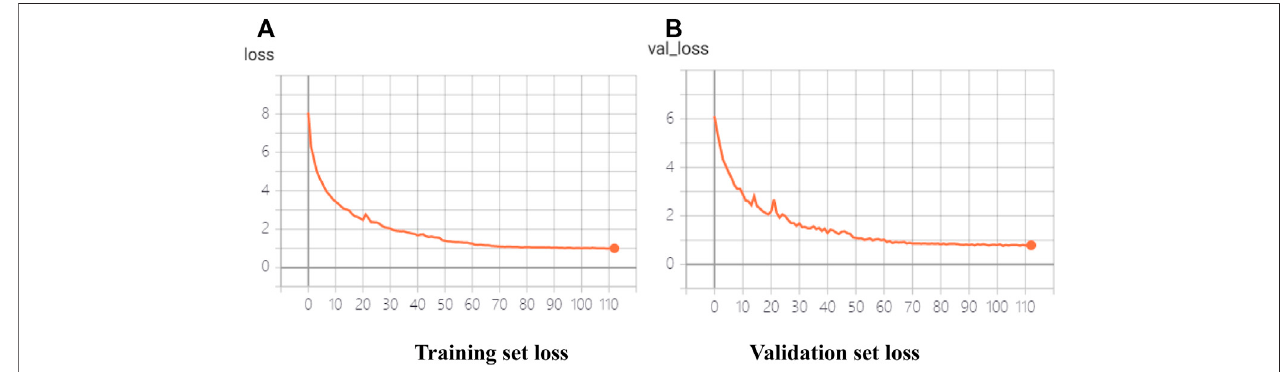
FIGURE 8 | Training of trial target detection model based on a lightweight convolutional neural network. (A) Training set loss. (B) Validation set loss.